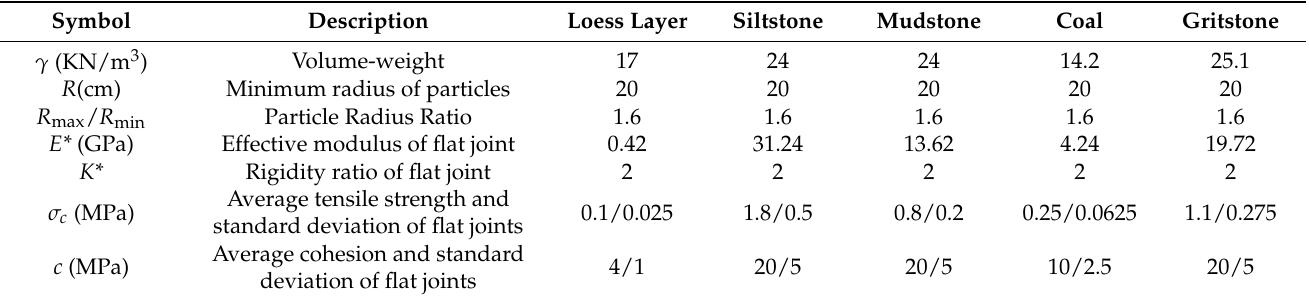
Table 2. Micromechanical parameters of strata.